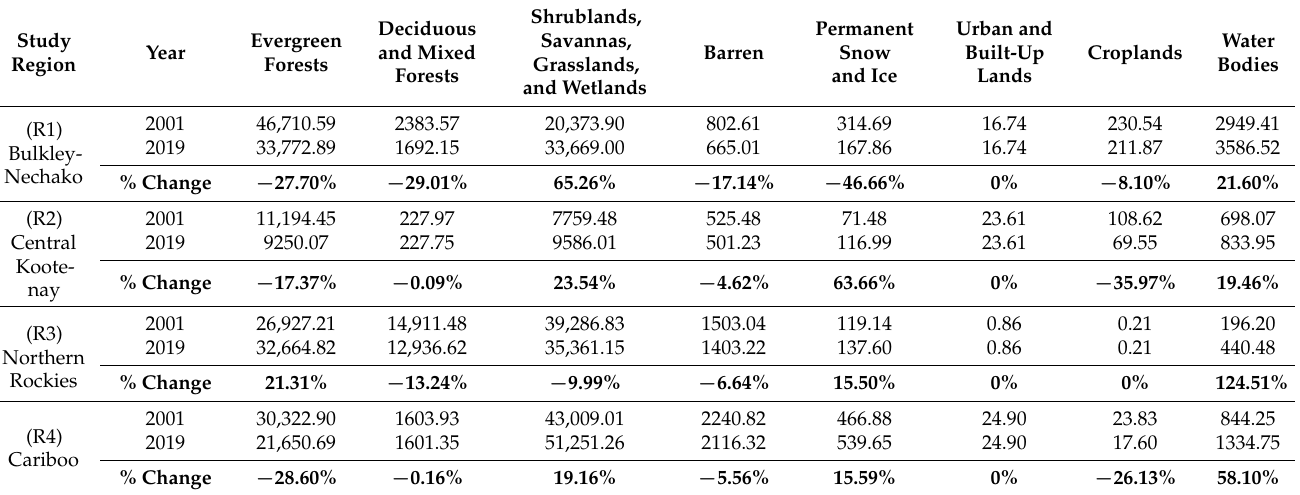
Table 1. Area covered by each land cover class in 2001 and 2019 for (R1) the Regional District of Bulkley-Nechako, (R2) the Regional District of Central Kootenay, (R3) the Northern Rockies Regional Municipality, and (R4) the Cariboo Regional